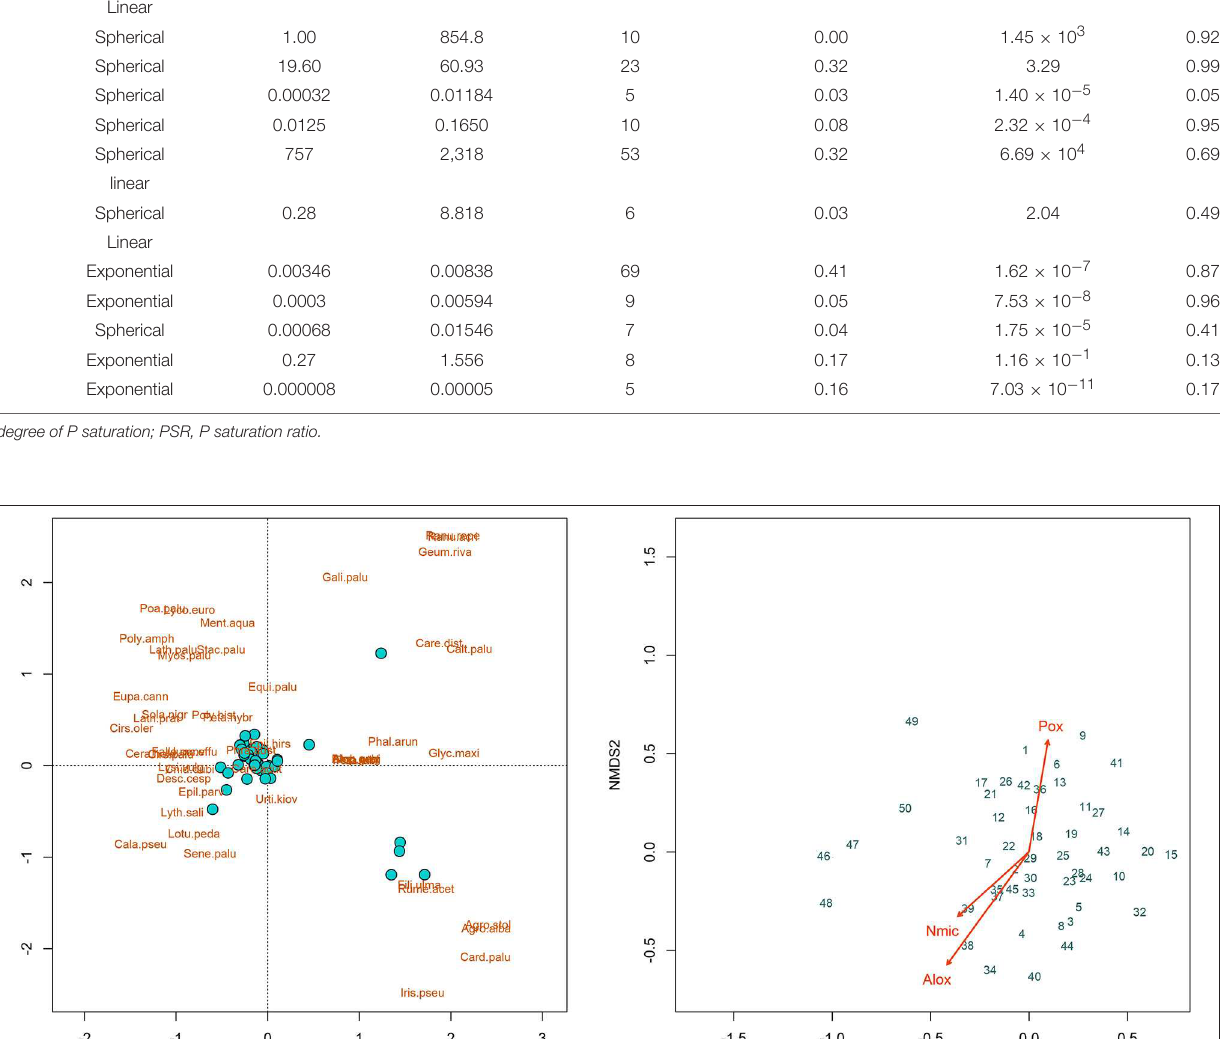
Frontiers in Environmental Science |